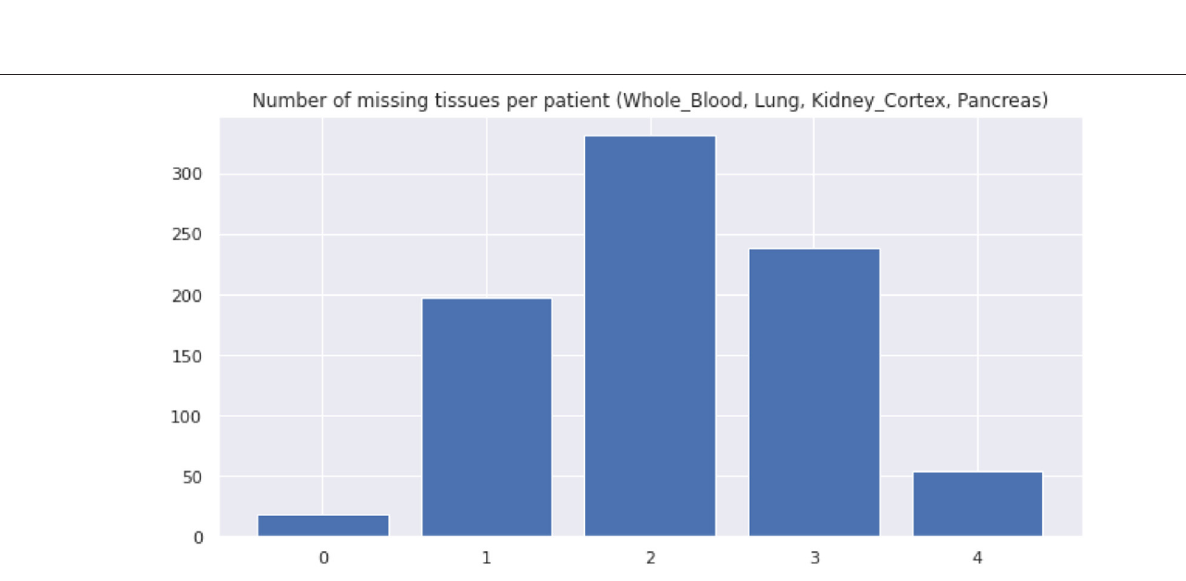
Frontiers in Genetics |